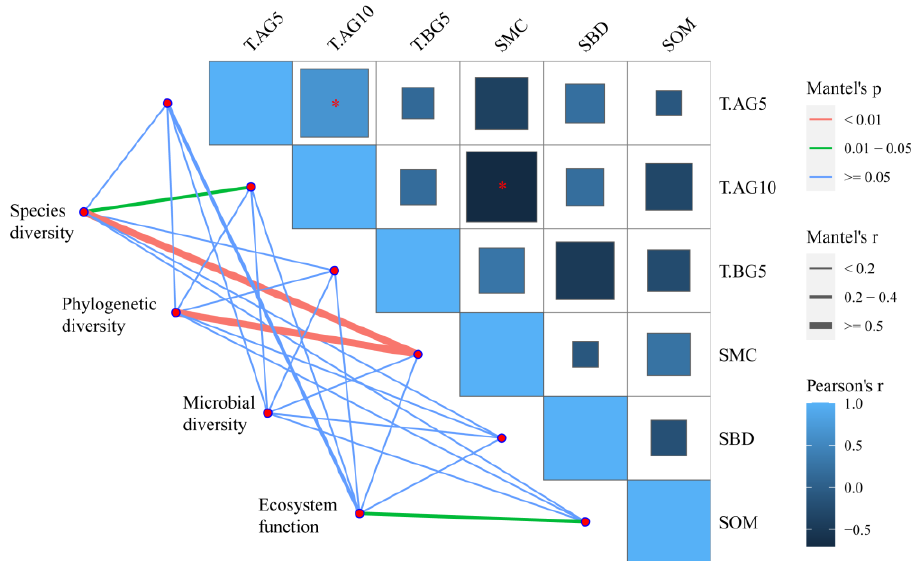
Figure 7. Environmental drivers of ecosystem structure and function. Pairwise comparisons of environmental factors are shown, with a color gradient denoting Spearman’s correlation coefficients. Ecosystem structure (biodiversity) and ecosystem function (biomass, biomass distribution and com- munity stability) were related to each environmental factor by partial Mantel tests. Edge width corresponds to the Mantel’s r statistic for the corresponding distance correlations, and edge color denotes the statistical significance based on 9999 permutations. T.AG5, T.AG10, T.BG5, SMC, SBD and SOM indicate temperature at 5 cm above ground, temperature at 10 cm above ground, temperature at 5 cm in soil, soil moisture content, soil bulk density and soil organic matter, respectively. * indicates the significance of correlation ( p = 0.05).